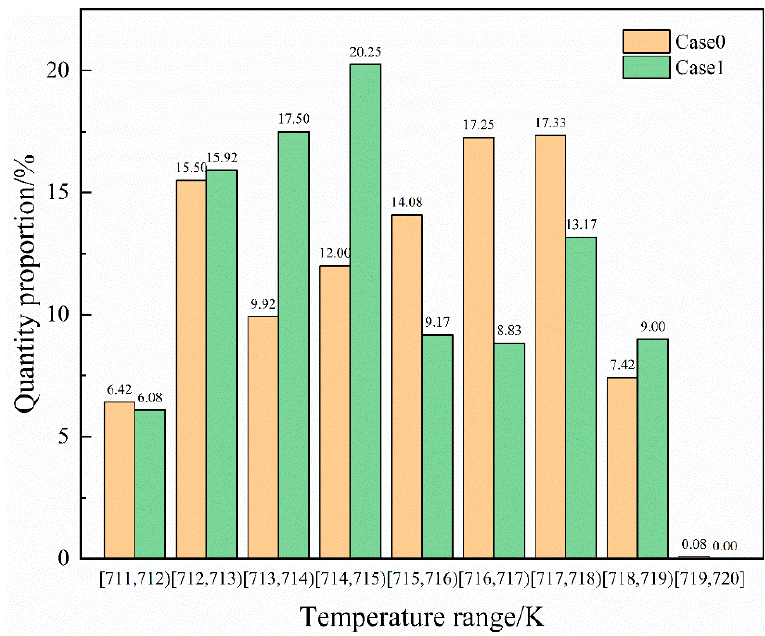
Figure 2. Relation between sinter temperature and quantity proportion.